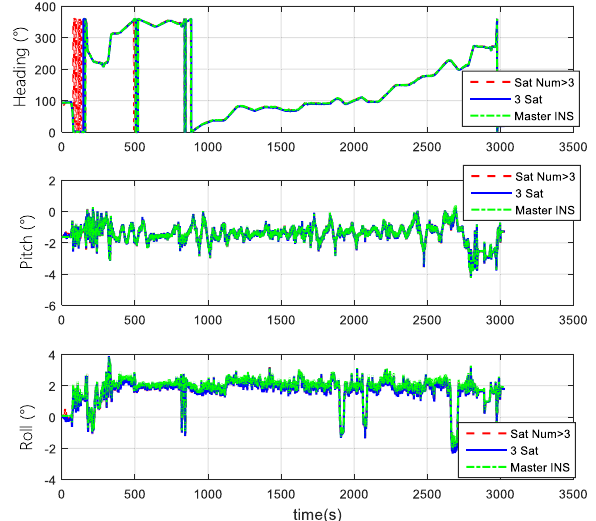
Figure 11. Attitude comparison of navigation by normal number of satellites and 3 satellites.